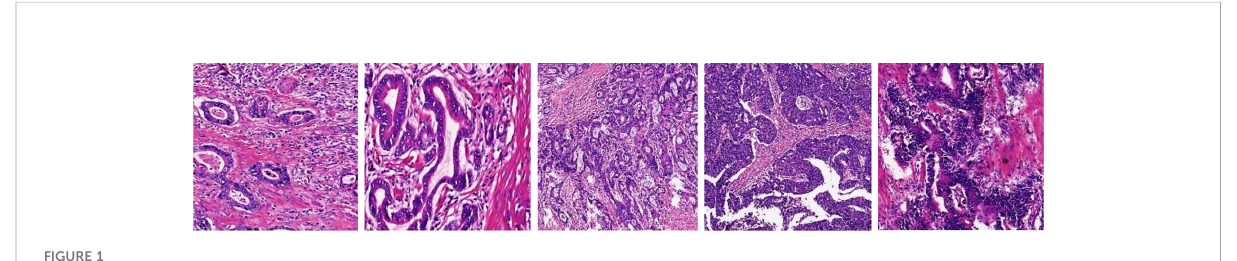
FIGURE 1 Example images demonstrating the complexity of GCHIs